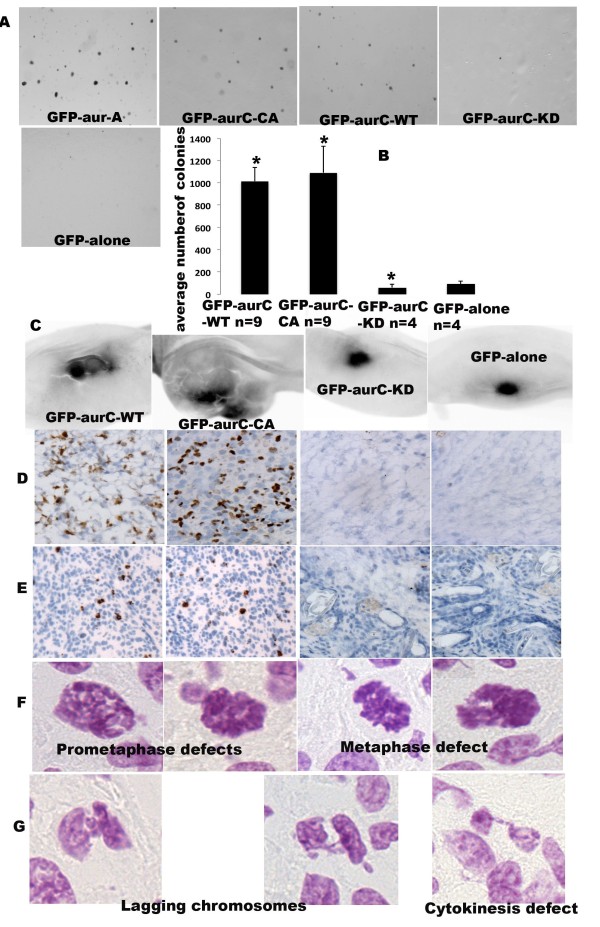
Soft agar assay, tumour formation and immunohistochemistry. (A) Foci of colonies of GFP-aurA, GFP-aurC-CA, GFP-aurC-WT stable cell lines and very negligible number of very small colonies of GFP-alone in soft agar assay. (B) Histogram of the average number of colonies. (C) Visualization of the tumours formed by injecting GFP-aurC-CA and GFP-aurC-WT stable cell lines, and the remaining injected cells of GFP-alone on the day of sacrifice using Kodak image station 2000. (D) Rabbit monoclonal KI-67, a proliferation marker from late G1 to M-phase staining (E) anti-phospho histone-H3 ser-10 (Millipore) and anti-HRP (Jackson) secondary antibodies and (F & G) Feulgen staining showing prometaphase defects, metaphase defects, lagging chromosomes at anaphase, and cytokinesis defect.